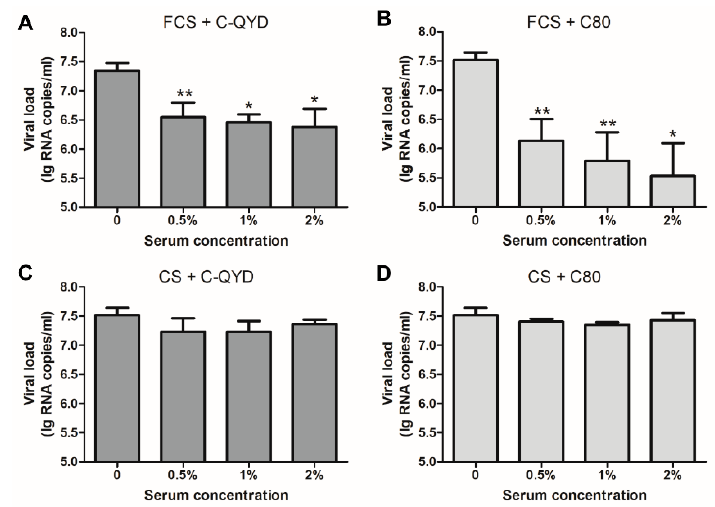
Figure 4. Quantitation of DHAV-1 genome replication in DEF cells inoculated with serum–virus mixture. The DHAV-1 C-QYD and C80 strains were individually preincubated with three concentrations (0.5%, 1%, and 2%) of FCS ( A , B ) and CS ( C , D ) at 37 °C for 1 h. DMEM–virus mixture was included as control. For each serum concentration, samples (cells + supernatant) were collected from three wells of 24-well plates. Viral load in each sample was quantified by RT-qPCR. Error bars represent the SD ( n = 3); * p < 0.05; ** p < 0.01.